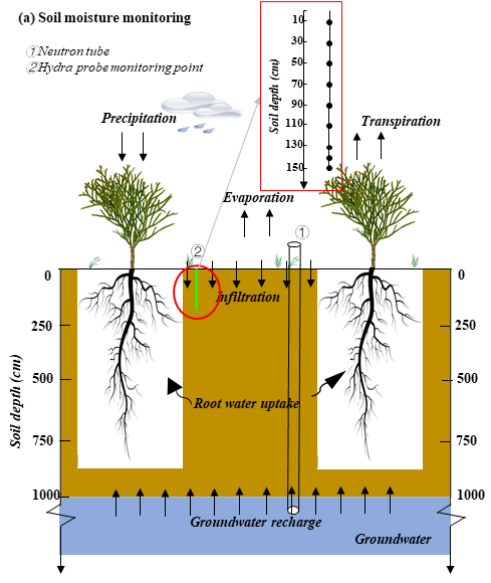
Figure 4. Monitoring of soil moisture in the H. ammodendron root zone .